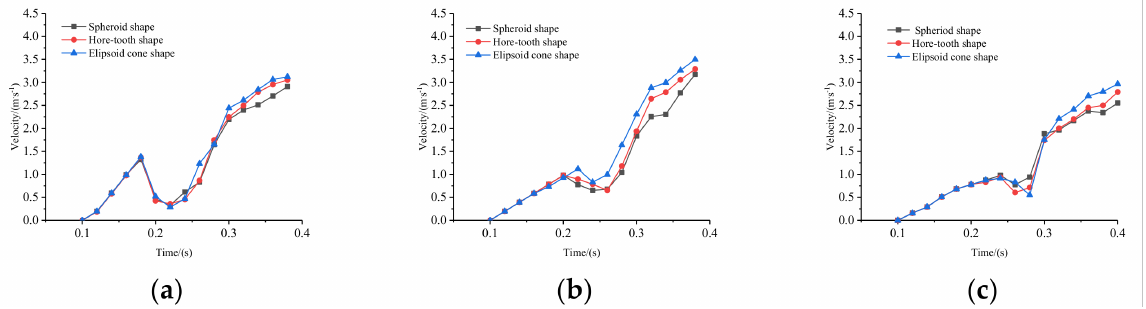
Figure 8. Variation of average seed velocities with time under different intake seed chamber positions. ( a ) Upper, ( b ) central, ( c )